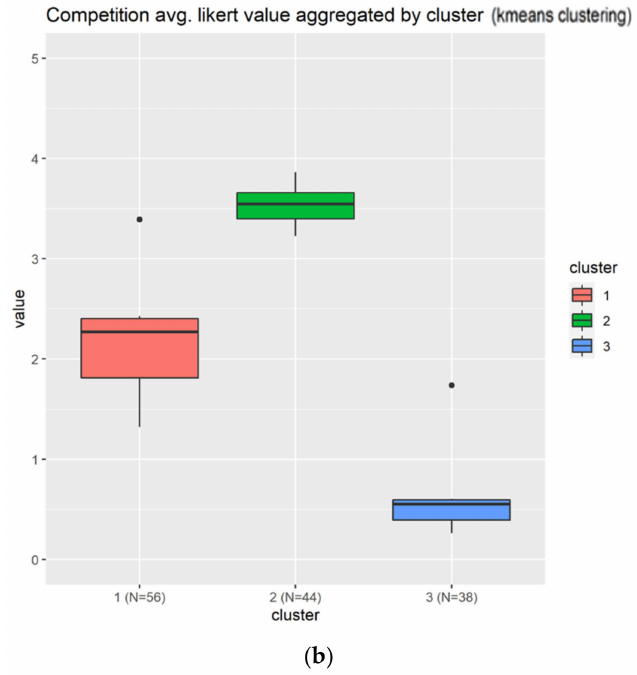
Figure 17. This figure shows the results for the Competition. There are three clusters in different colors. The ( a ) shows the results based on each question, meanwhile the ( b ) shows the information condensed in